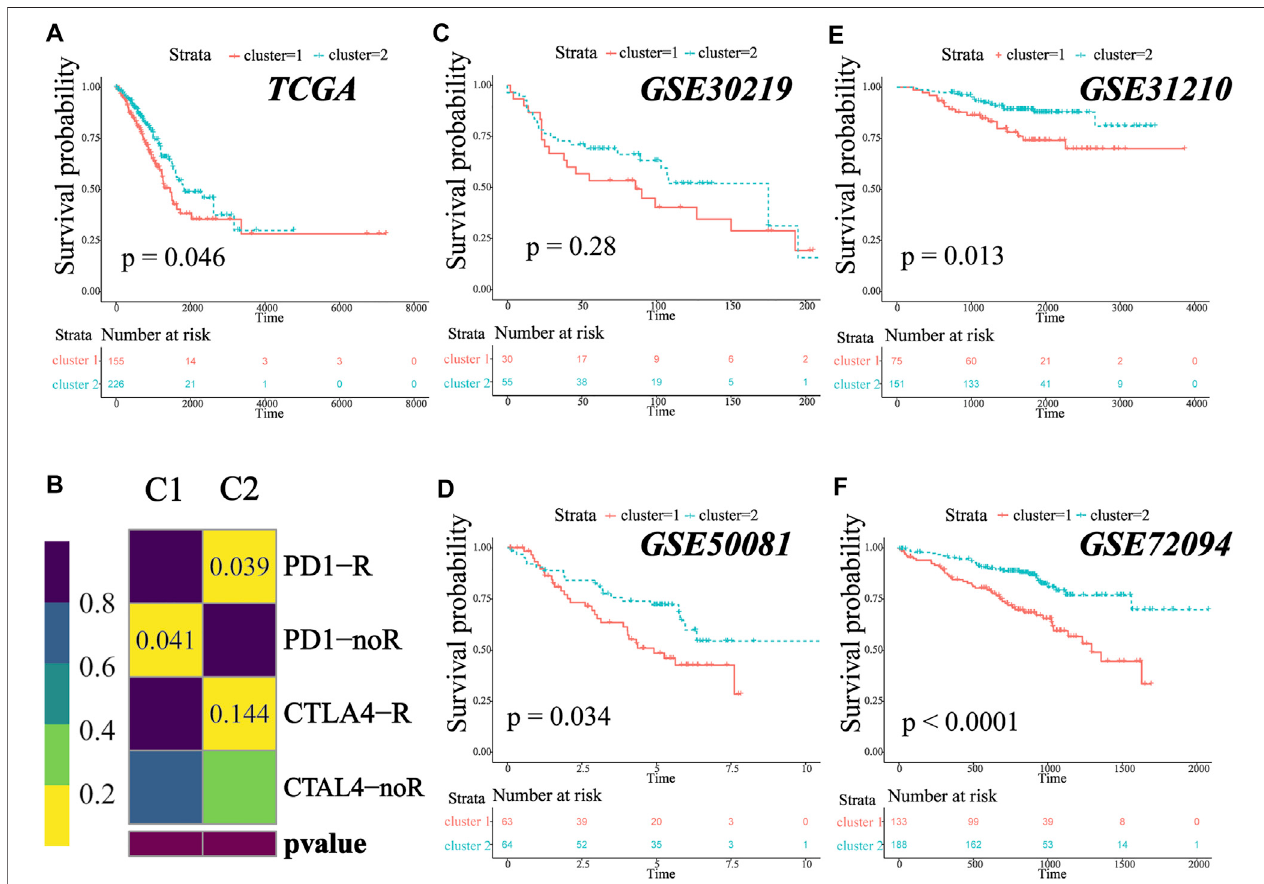
FIGURE 6 | MATH-based subtype was a prevalent phenomenon in early-stage LUAD. (A) . Kaplan – Meier survival analysis revealed signi fi cantly better overall survival in patients in C2. (B) Submap analysis for predicting the likelihood of immunotherapy response for C1 and C2. (C – F) Different clinical overall survival outcomes between C1 and C2 in GSE30219, GSE50081, GSE31210, and GSE72094.